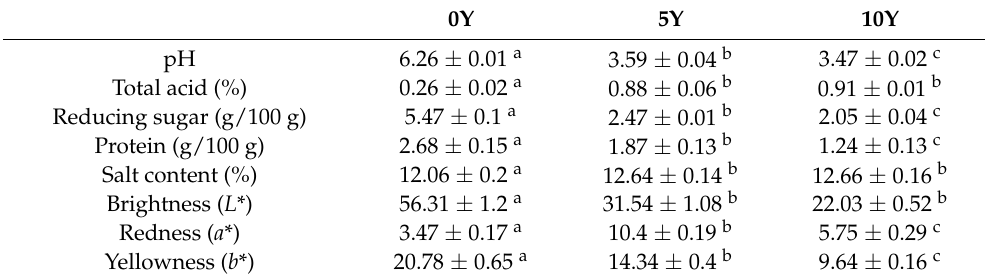
Table 1. Changes in physicochemical properties of ultra-long-term industrially fermented